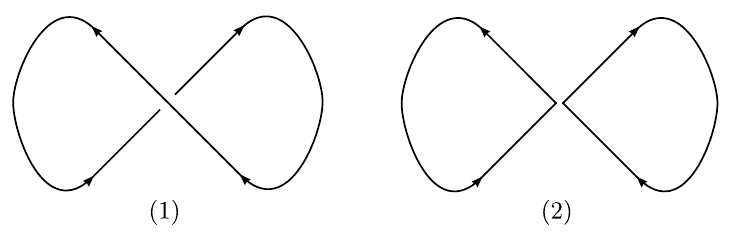
Figure 1 . The relevant contours for the multiplicative renormalization of self-intersecting Wilson